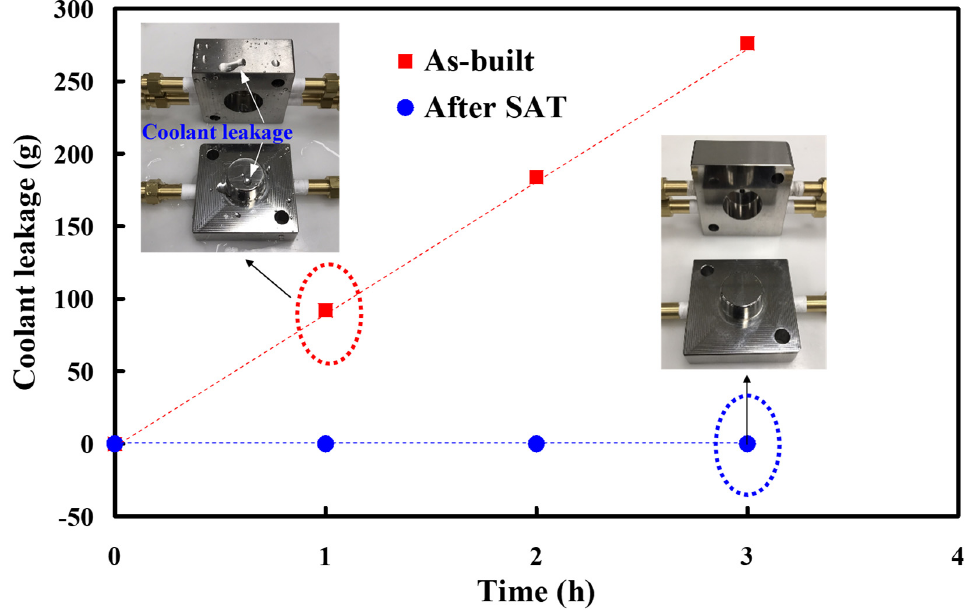
Figure 8. Results of coolant leakage test for an injection mold with CCC. Wax patterns can be fabricated through low-pressure wax injection molding. We car- ried out wax injection molding to study the difference in the cooling times of the wax pattern for injection molds with and without coolant leakage. Figure 9 shows the cooling times of the wax patterns for injection molds. The cooling times of the wax patterns fabri- cated by the injection mold with and without coolant leakage were 22 s and 39 s, respec- tively. Note that a distinct defect of the molded wax pattern, named short shot (an incom- pletely filled mold cavity [18,19]), was observed when the mold had coolant leakage. In this study, injection molds were fabricated by a hexagonal scanning strategy because it provides a regular arrangement of pores inside the injection mold. Figure 10 shows the microstructural evolution of the injection mold after SAT with the optimized procedure.